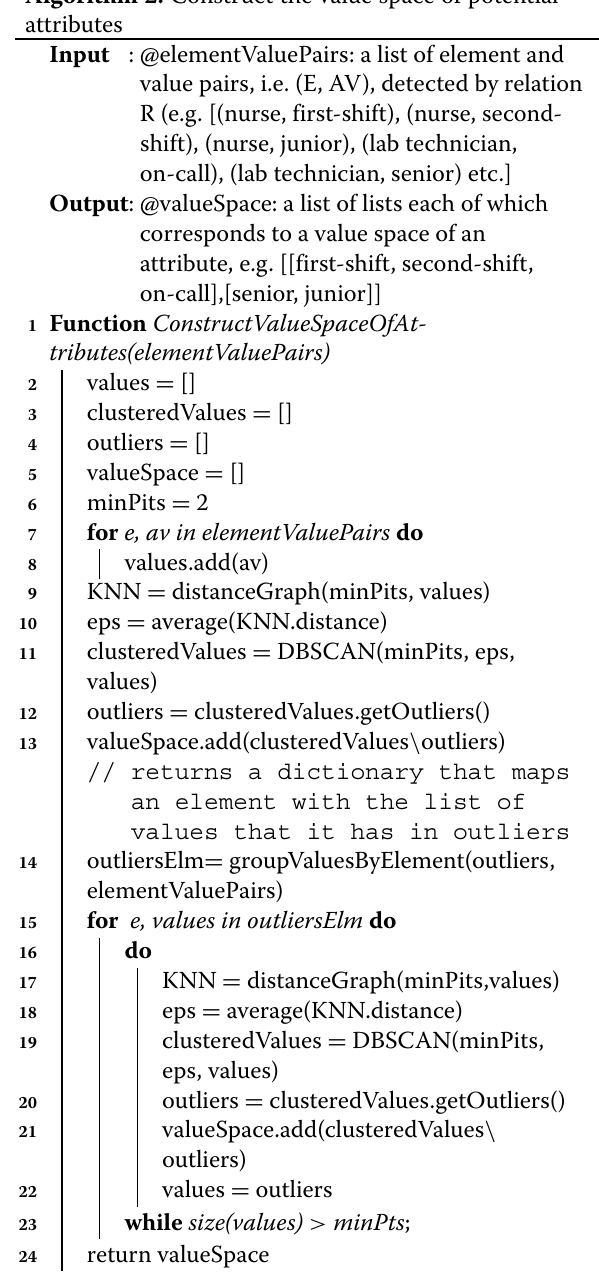
Algorithm 2: Construct the value space of potential attributes